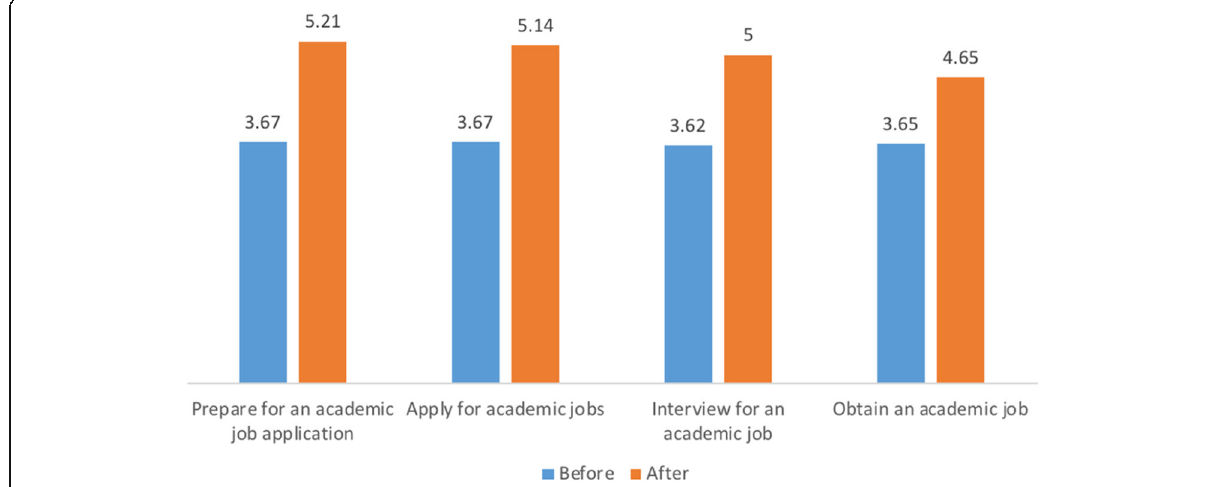
Fig. 9 Confidence in job